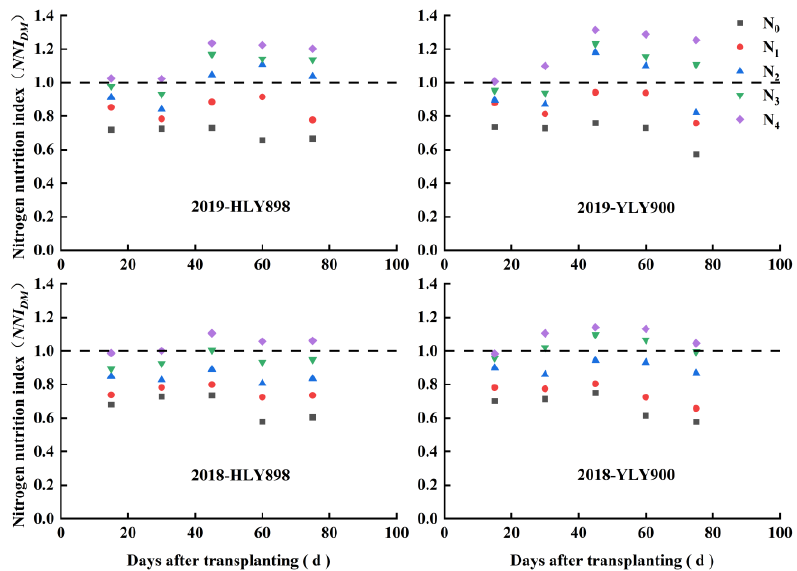
Figure 8. Dynamic changes in NNI DM according to days after transplanting (d) shown for the varieties Huiliangyou 898 (HLY 898) and Yliangyou 900 (YLY 900) according to the season (2018 or 2019).